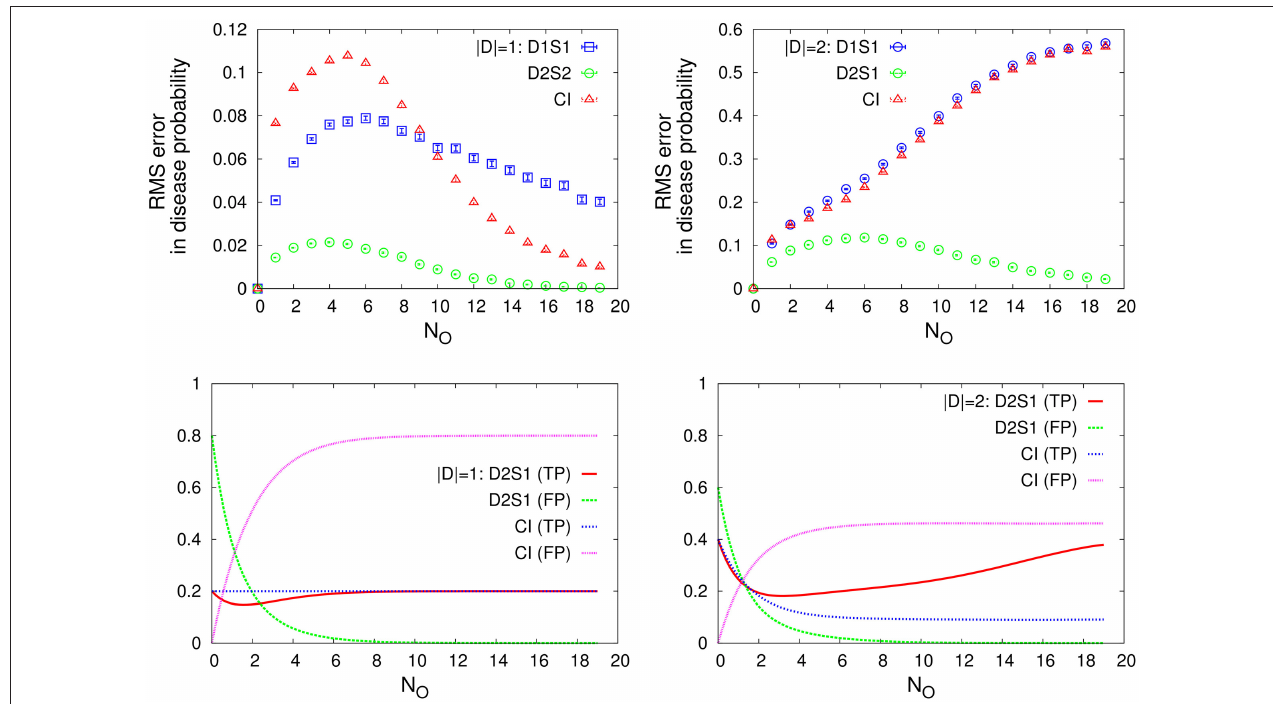
FIGURE 2 | (Top) The RMS error in the disease probability and (Bottom) the accuracy of the disease predictions, true positive (TP) and false positive (FP), for cases D D in which only one ( 1) or two diseases ( 2) are present in the disease hypothesis. We compare the results obtained by the D1S1 and D2S1 models with the | | = | | = (CI) results obtained by the Bayes’ rule assuming the conditional independence of the signs and causal independence of the diseases. The model parameters are obtained from the conditional marginals of the exponential true model. Here N D 5, N S 20, and N O is the number of observed signs with the true values. The prior = = D probabities are chosen such that N D P 0 ( D a 1) . The data are results of averaging over 1,000 independent realizations of the true model and the true disease = = | |